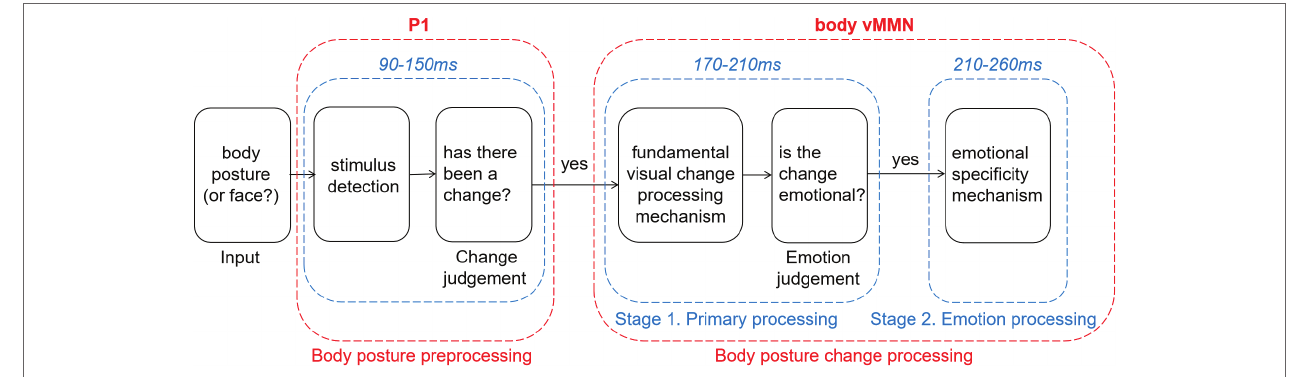
FIGURE 5 | Two-stage model of processing changes in body